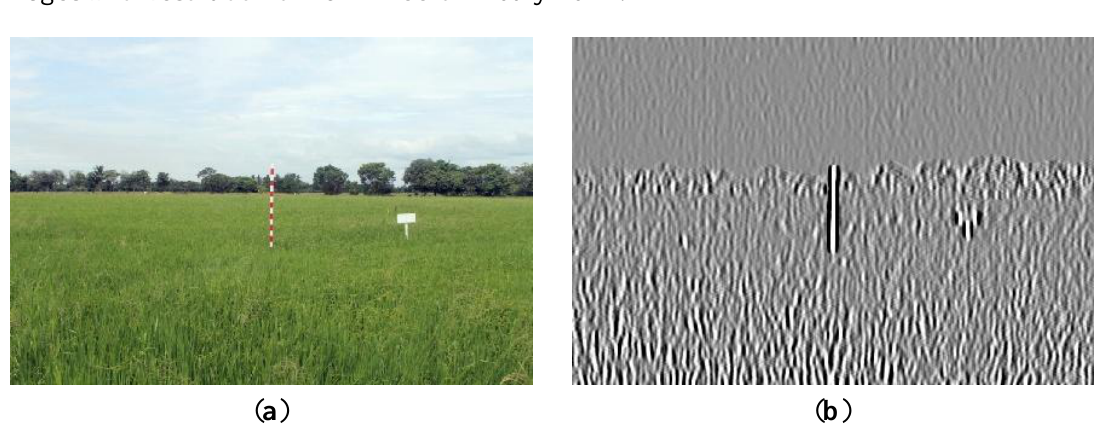
Figure 26. Comparison between ( a ) RGB and ( b ) 7 × 7 modified filtered excess green images with resolution of 432 × 288 on 1 July